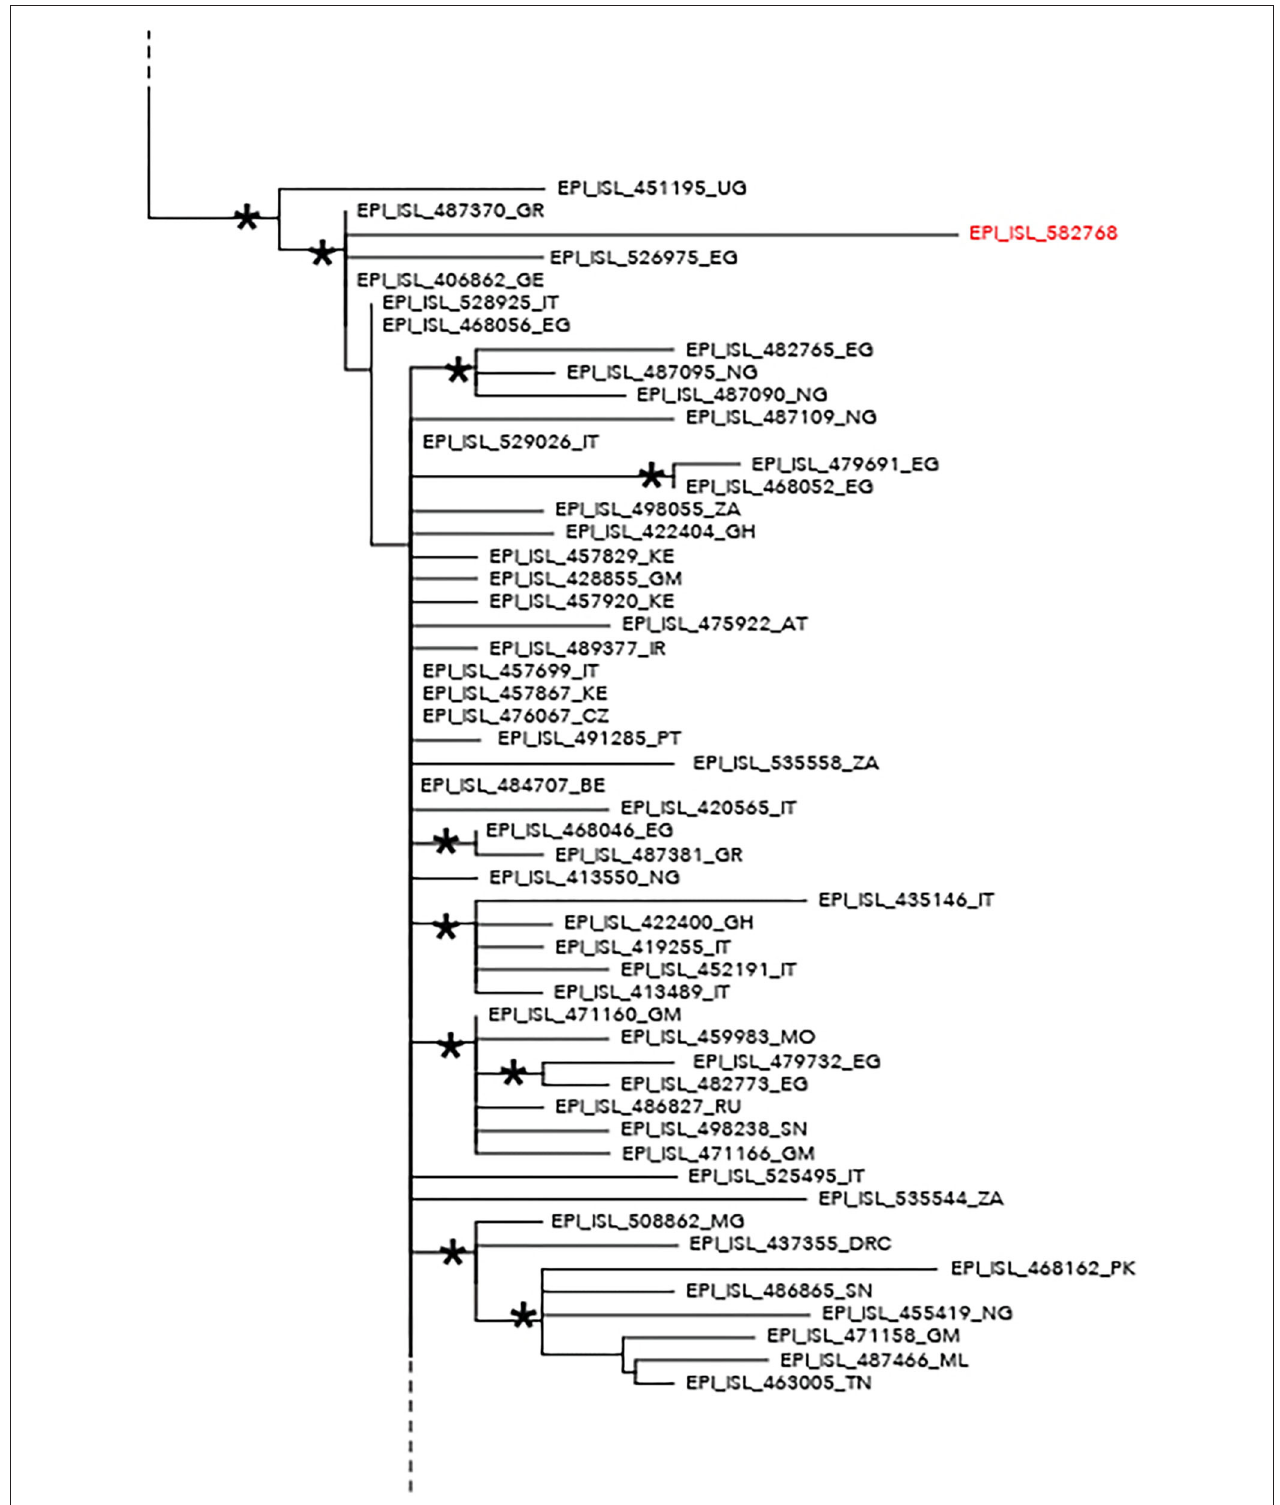
FIGURE 2 | Phylogenetic analysis highlighting the selected clade extrapolated from the whole tree and including the severe acute respiratory syndrome coronavirus 2 (SARS-CoV-2) strain EPI_ISL_582768 (highlighted in red) intermixed among other SARS-CoV-2 B–B.1 lineage genomes. This strain appeared intermixed among other genomes from different countries and more proximal to strains from Egypt (EPI_ISL_526975), Greece (EPI_ISL_487370), Germany (EPI_ISL_406862), and Uganda